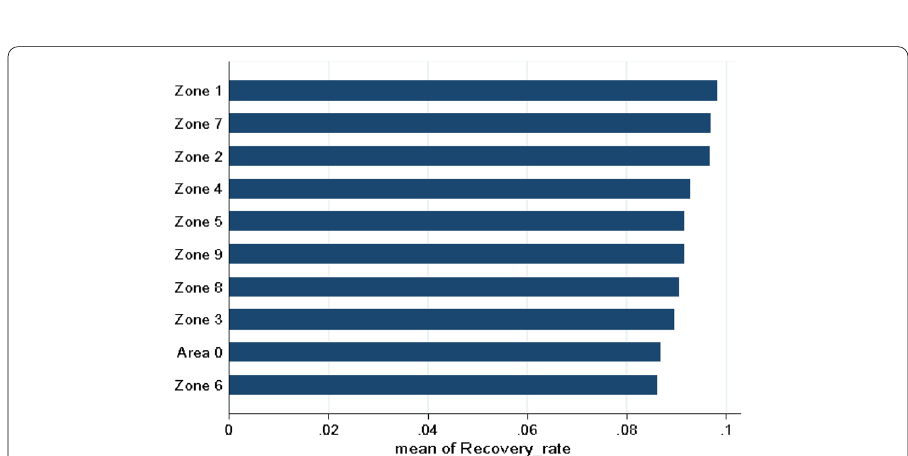
Fig. 8 Mean-recovery rate by country. Notes. This graph shows the average distribution of the Recovery Rate of the loans issued on the LendingClub platform by each country. The US is classified in 10 zones based on the borrower’s first three digits of the ZIP